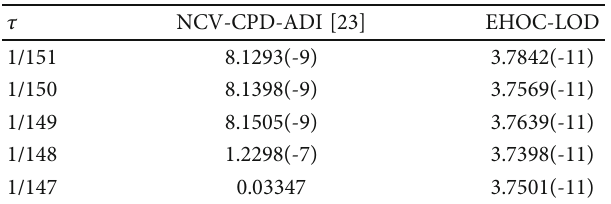
Table 7: The L ∞ norm error with h = for Example 3.